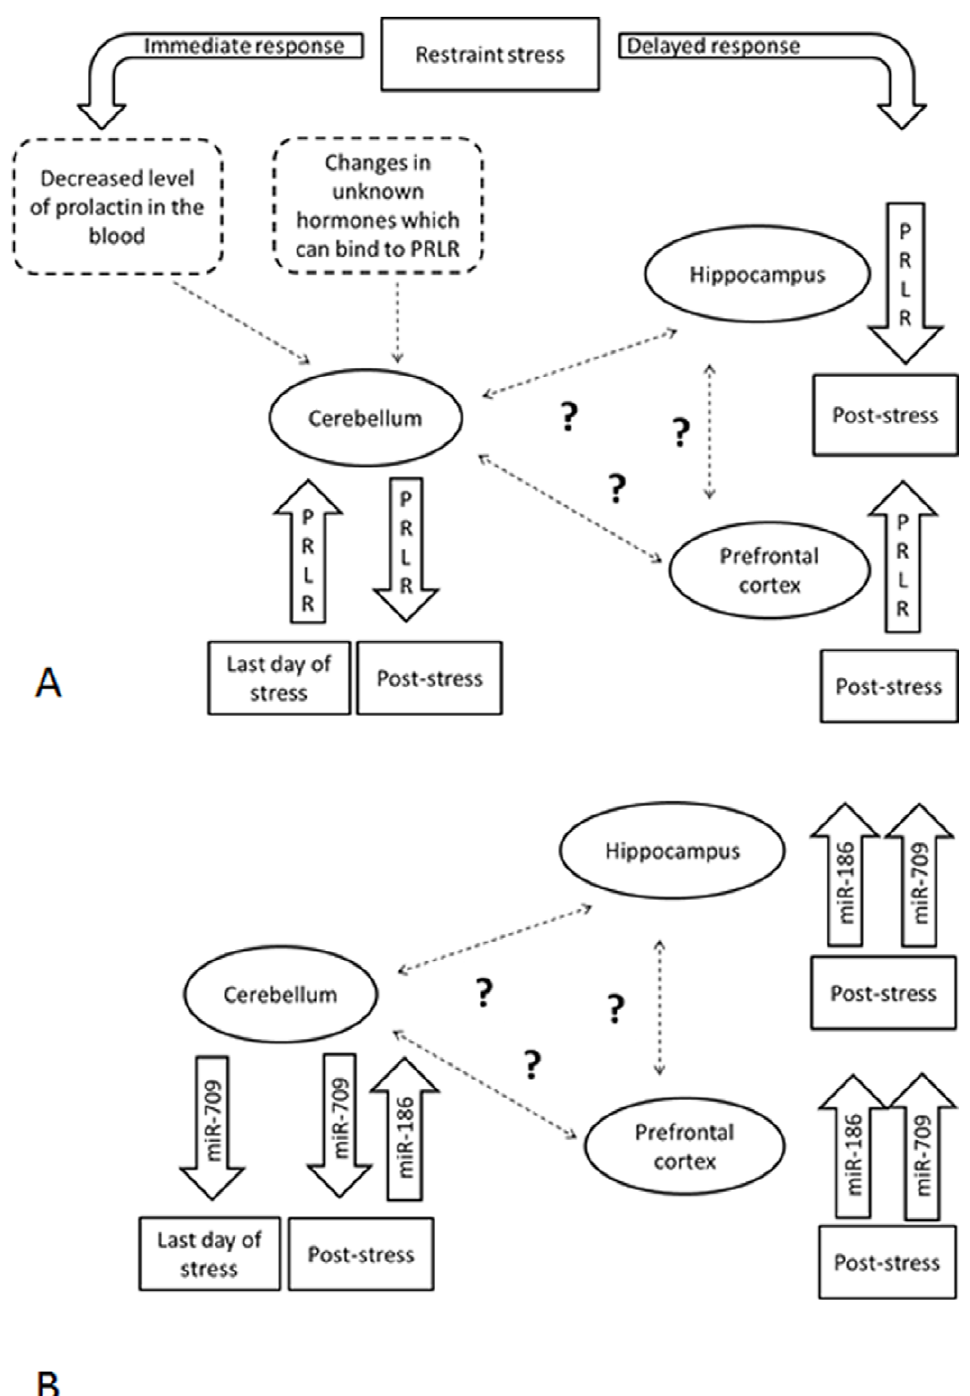
Figure 11. Hypothetical scheme of the stress response in the brain. A: Changes in PRLR expression. B: Changes in miRNA expression. We hypothesize that restraint stress causes a different response in cerebellum and other brain regions, such as hippocampus and prefrontal cortex. There might be an immediate response in the cerebellum reflected by an increase in the level of prolactin receptors after two weeks of stress. After the recovery from stress the expression of PRLR returns to normal in cerebellum, but is down-regulated in hippocampus and up-regulated in prefrontal cortex. Negative correlation between prolactin and its receptors [42] suggests that levels of prolactin in the cerebellum may decrease after stress. Alternatively, changes in expression levels of PRLR may occur in response to changes of other hormones or cytokines that bind to PRLR. Similarily, immediate responses in the cerebellum could be reflected in a decrease of miR-709 levels after two weeks of stress. After recovery from stress the expression of miR-709 is up-regulated in hippocampus and prefrontal cortex.